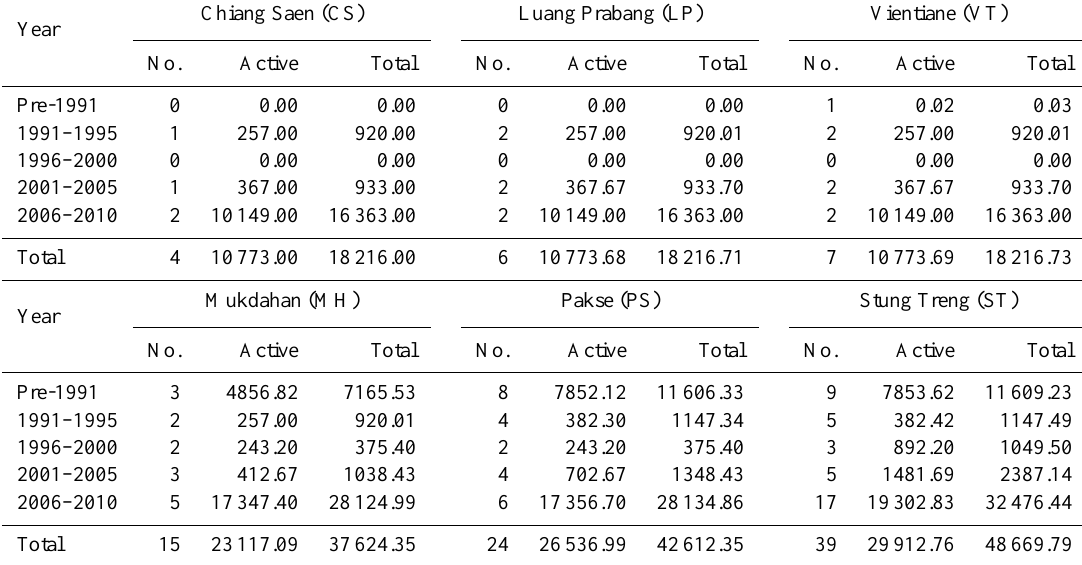
Table 2. Hydropower reservoir active and total storage (Mm 3 ) above monitoring stations in operation by 2010.